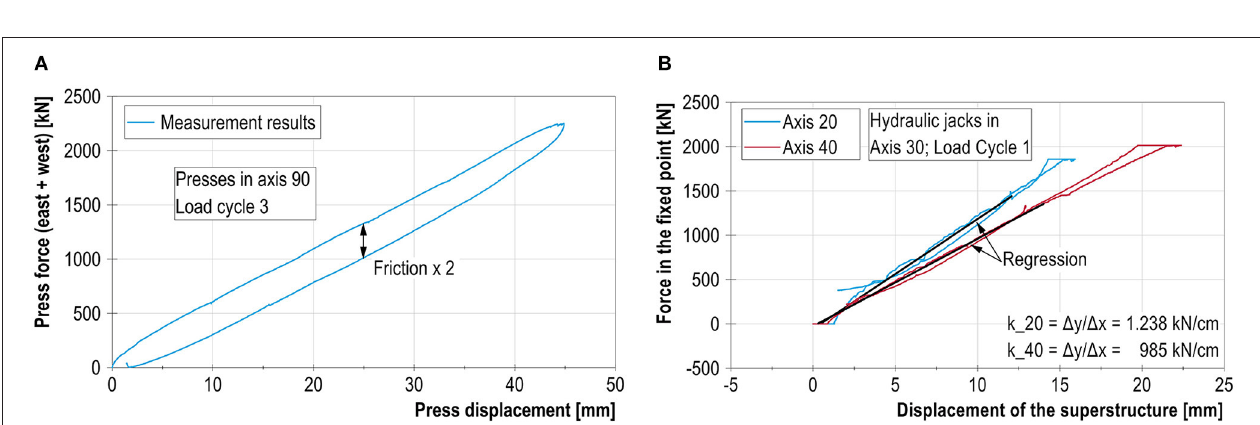
FIGURE 7 | (A) Determination of the friction in the sliding bearings. (B) Determination of the stiffnesses of the piers at axes 20 and 40 during load cycle 1.